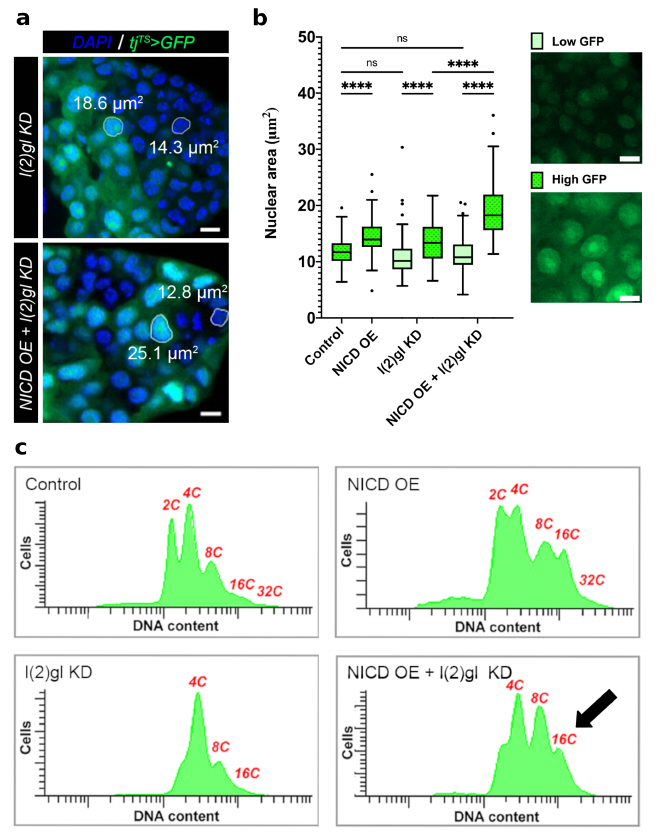
Figure 3. NICD accumulation promotes nuclear size heterogeneity. ( a ) Confocal image comparing nuclear size of tumor cells between l(2)gl KD and NICD OE + l(2)gl KD genotypes. Each image is of the posterior tumor of a mid-staged egg chamber. Example area measurements are shown for larger (high GFP-expressing) and smaller (low GFP-expressing) cell nuclei. Scale bar = 5 µ m. ( b ) Box and whisker plot of nuclear area measurements between high and low GFP-expressing cells between Control, NICD OE, l(2)gl KD, and NICD OE + l(2)gl KD genotypes (left). Example images from NICD OE + l(2)gl KD show cells from the low GFP and high GFP groups without DAPI signal for a better comparison (right). Scale bar = 5 µ m. N = 100 nuclei in 5 egg chambers from different individuals. Comparisons from the post hoc Tukey HSD are shown. (Ns) not significant, (****) p < 0.0001. ( c ) Flow cytometry analysis of DNA content for all genotypes. Copies of the genome are labeled (2-32C (GFP) in red. NICD expression increases the proportion of polyploid cells (8-16C),